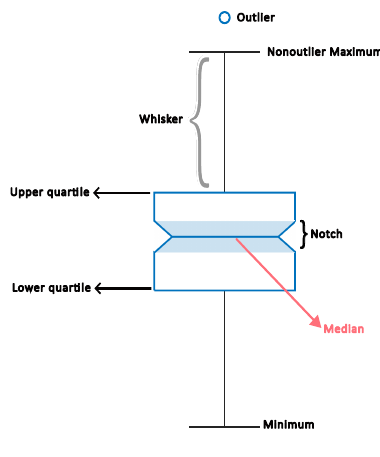
Figure 6. Legend of the information in the box charts. walls are noticeable. The central tendency of the three cameras is slightly offset. More precisely, the percentage change of